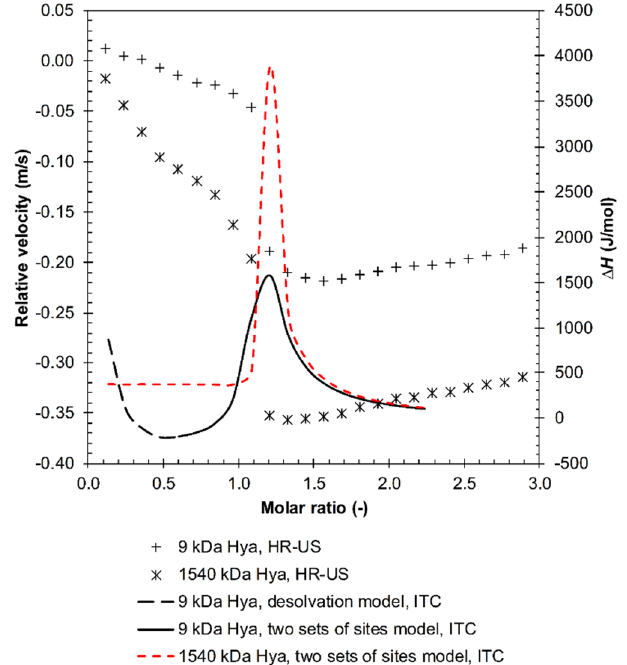
Figure 11. Comparison of the fitted ITC records and the measured relative ultrasound velocity changes during the titration of arginine decamer (hydrochloride form) into 9 and 1540 kDa hyaluronan solutions in water (25 °C, 11.6 MHz).